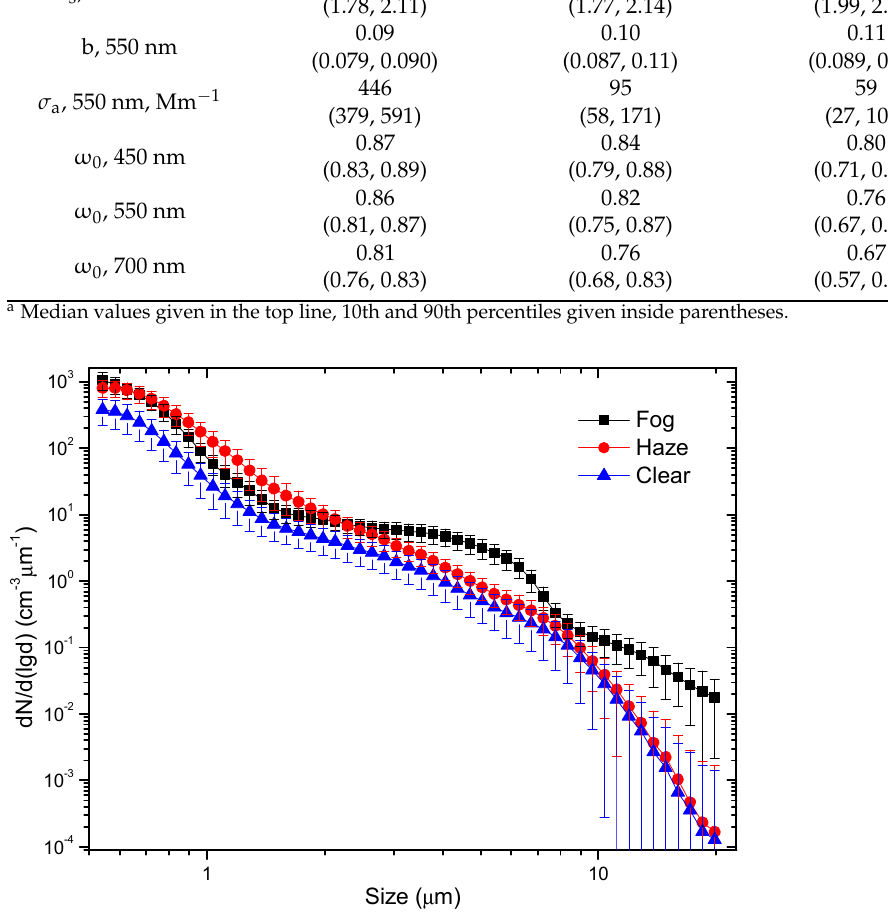
Figure 5. Mean size distributions for fog, haze and clear periods.